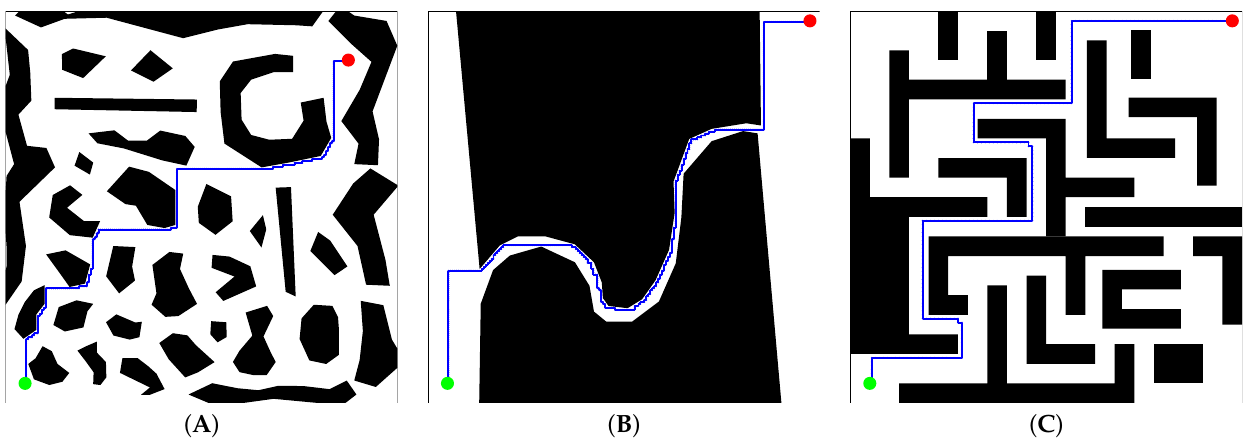
Figure 6. Paths achieved by A* when w = 1 for test cases ( A – C ), respectively.